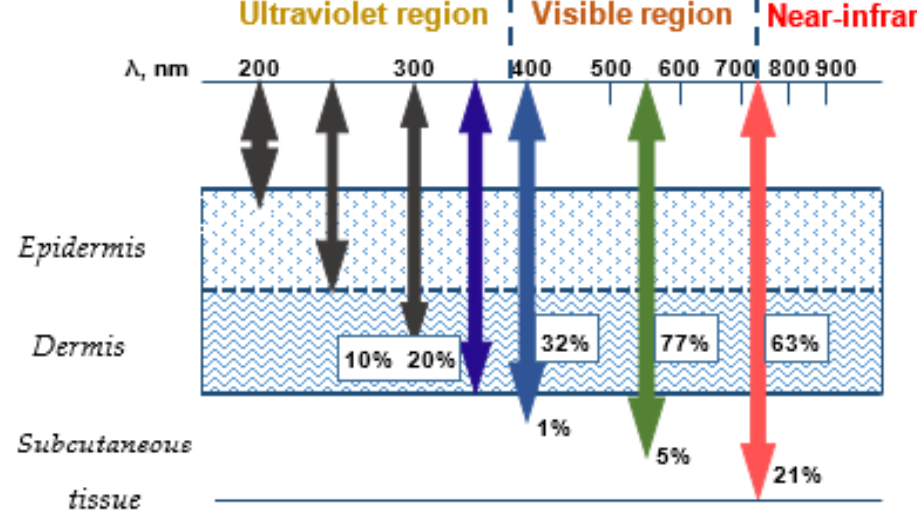
Figure 2. The absorption